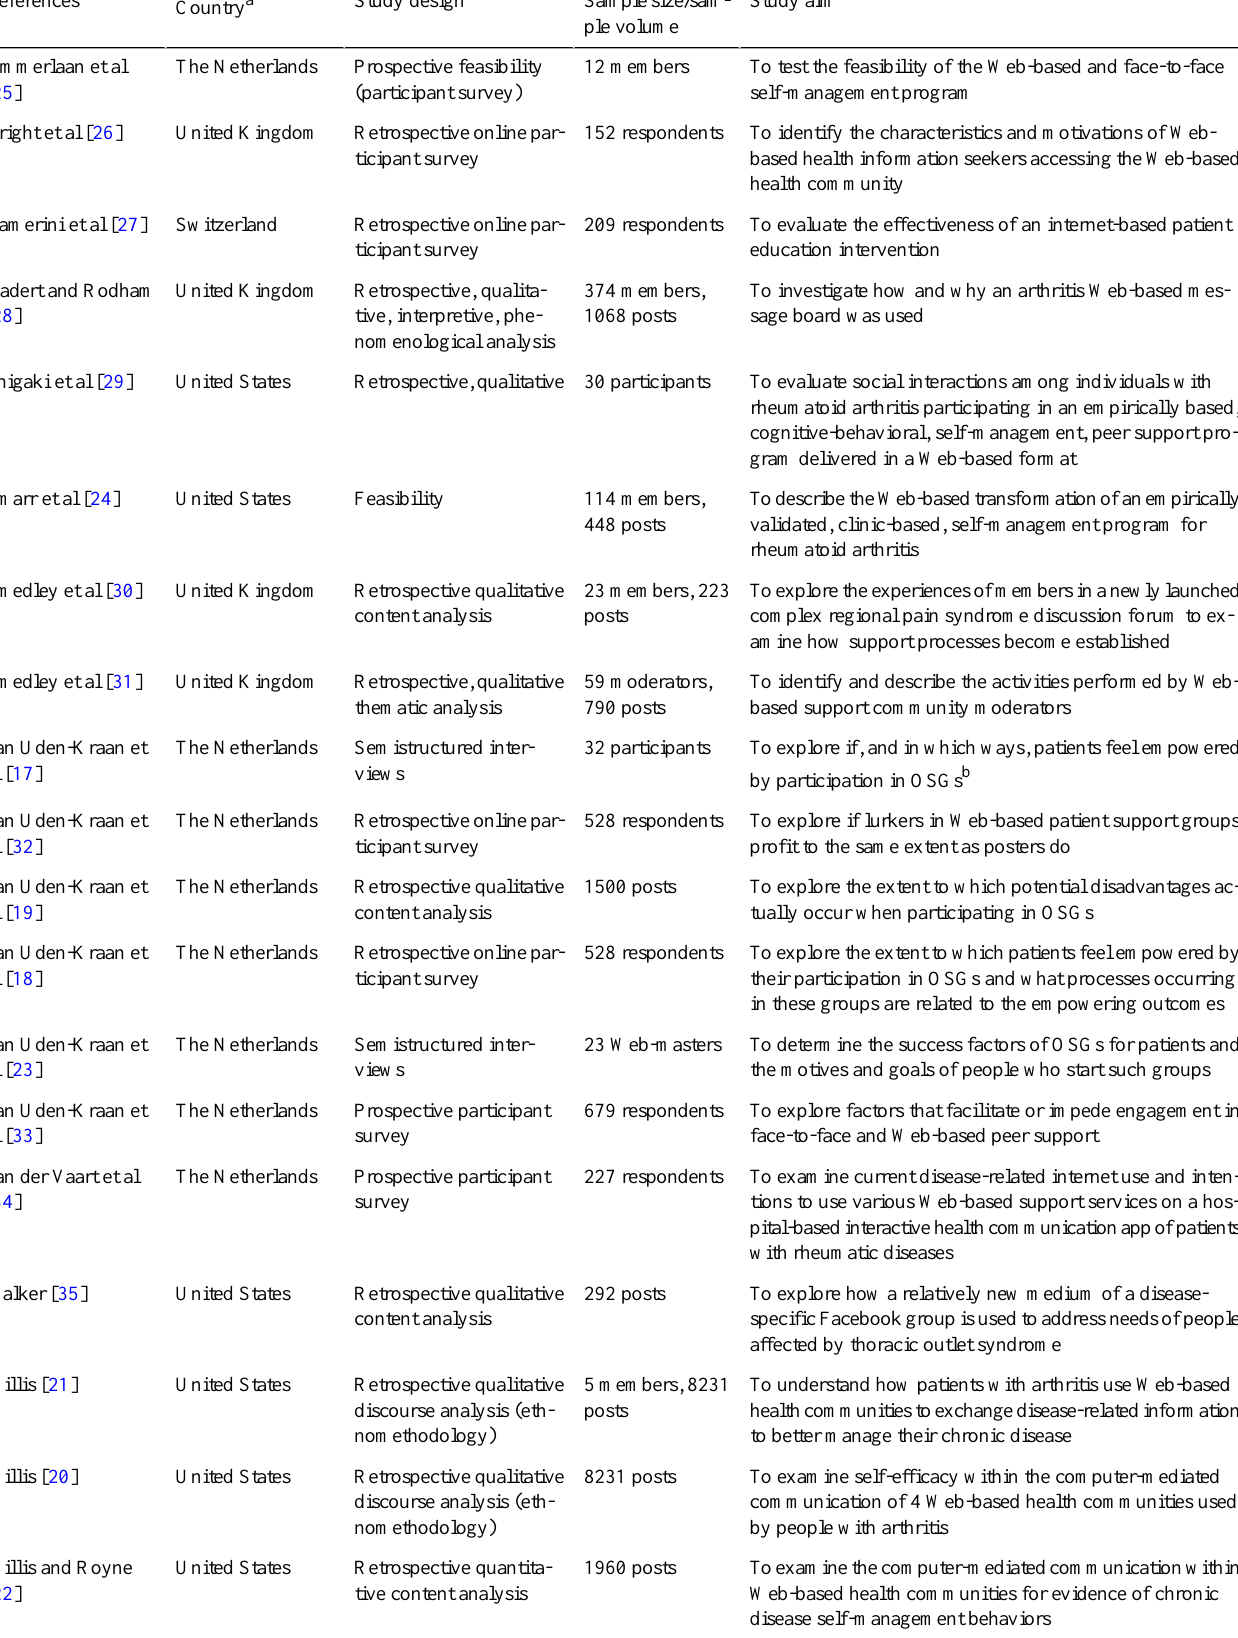
Table 1. Design, sample size, and aims of included